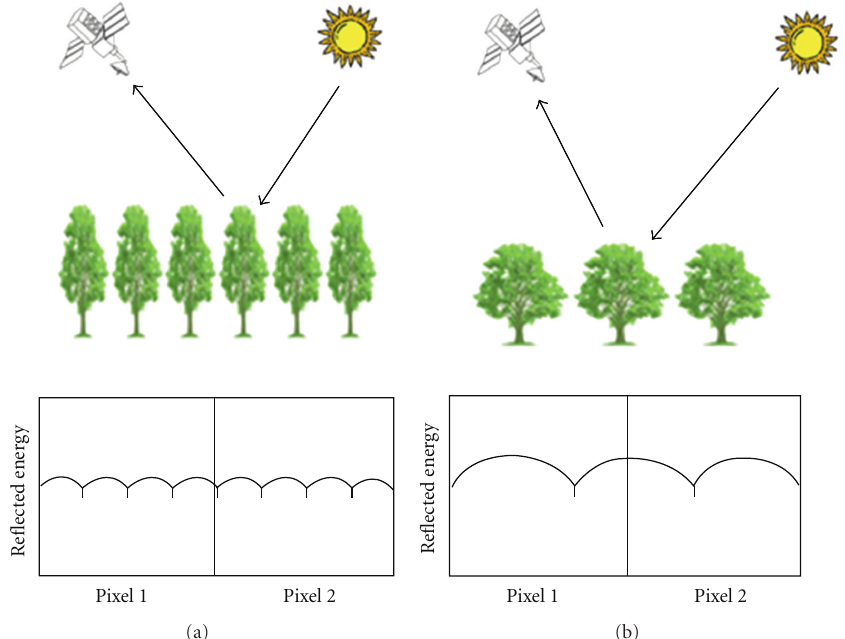
Figure 1: Size class e ff ect on remotely sensed data: (a) small crown trees and (b) large crown trees (courtesy of Al-Hamdan et al. [25]).